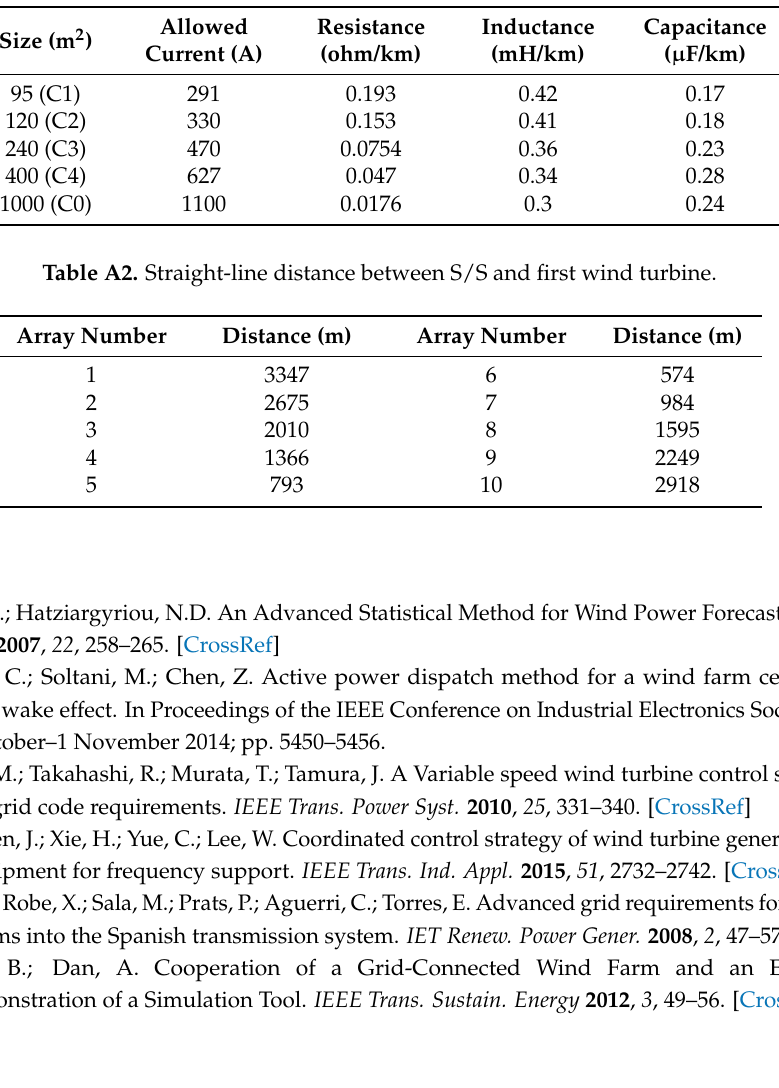
Table A1. Numerical transmission line data.